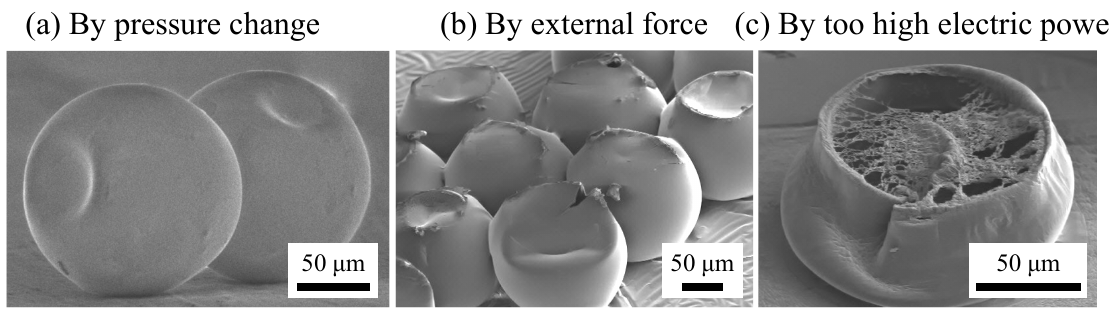
Figure 6. Partially etched microcapsules using focused ion beam (FIB) lithography showing shell membranes and inner cavities.